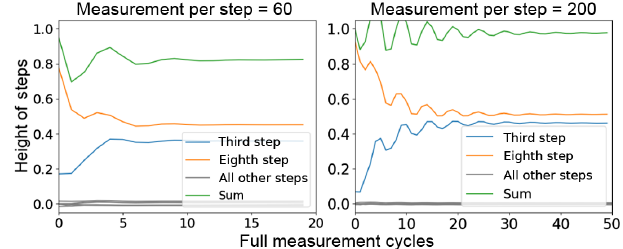
FIG. 12. Flow after each measurement step for n ¼ 60 and n ¼ 200 . For both, ð T= 8 Þ ¼ ð π = 2 Þ